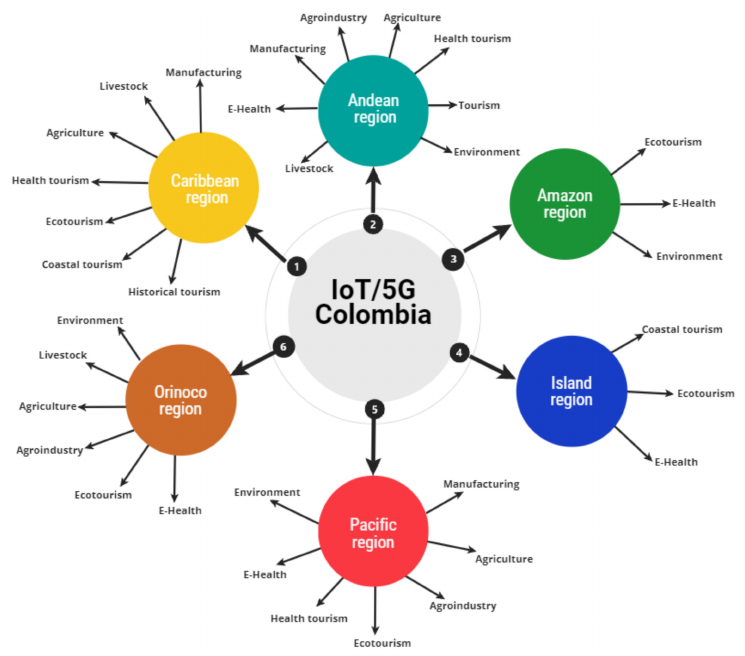
Figure 4. IoT/5G applications potential summary in natural regions of